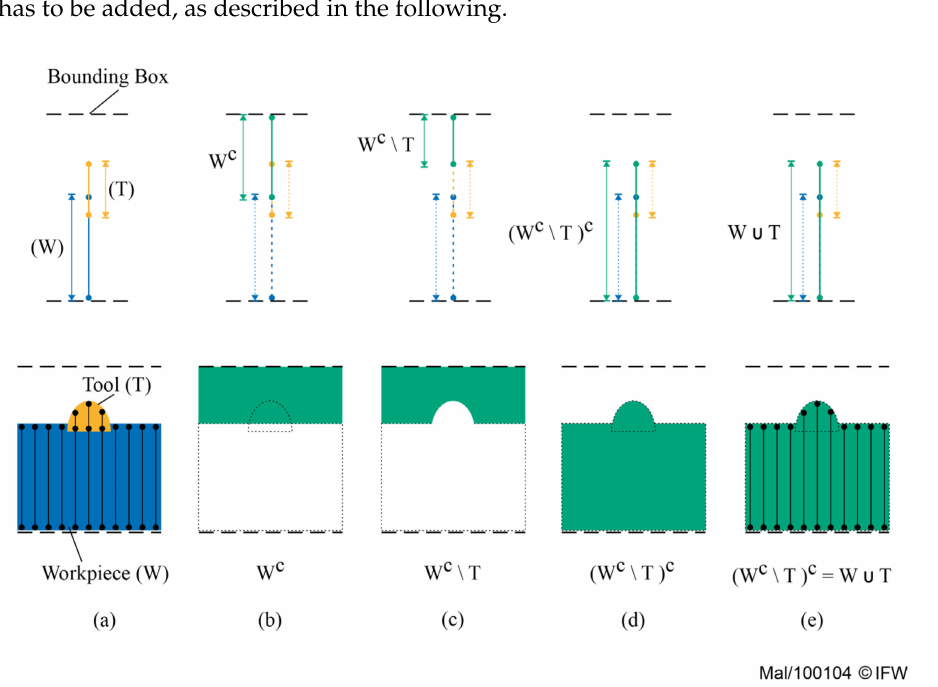
Figure 3. Calculation steps for material deposition and transformation of the virtual tool shape into workpiece. Upper row: Calculation steps for a single Dexel line. Lower row: Sequence of calculation steps for the entire Dexel model. ( a ) Initial situation; ( b ) complement of workpiece; ( c ) subtraction of virtual tool; ( d ) complement; ( e ) resulting union of workpiece and deposited material with